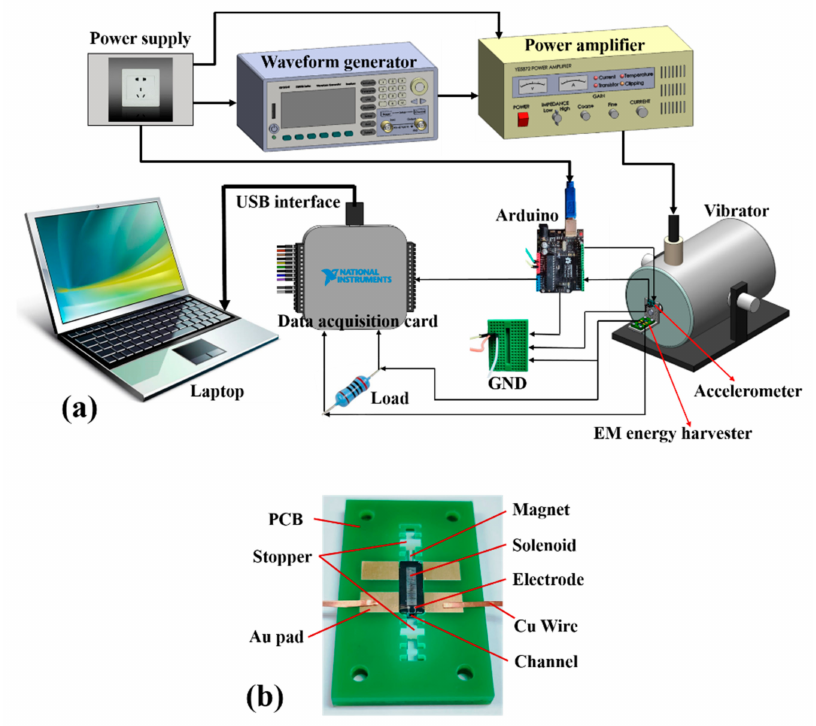
Figure 6. Schematic of the testing system. ( a ) Testing apparatus; ( b ) energy harvester prototype for